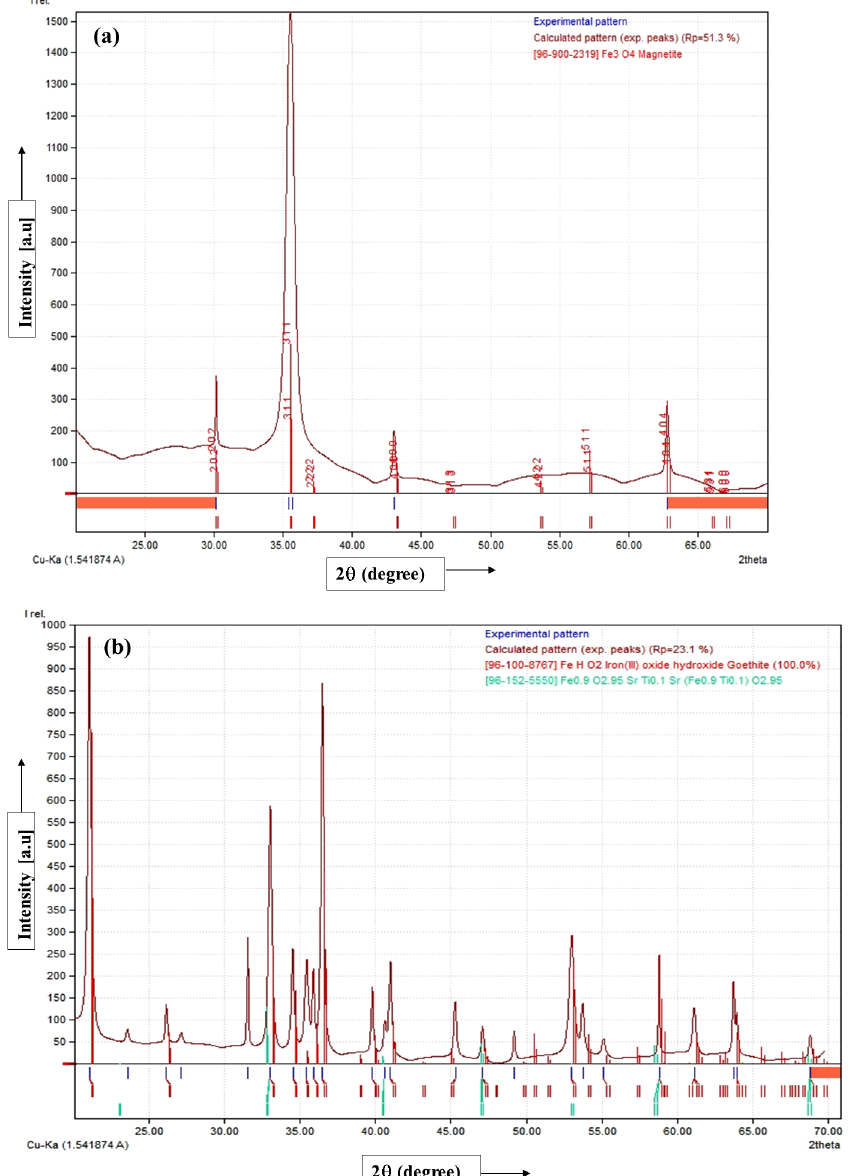
Figure 1. XRD pattern of (a) coated (Fe 3 O 4 ) nanoparticles, (b) uncoated (Fe 3 O 4 )